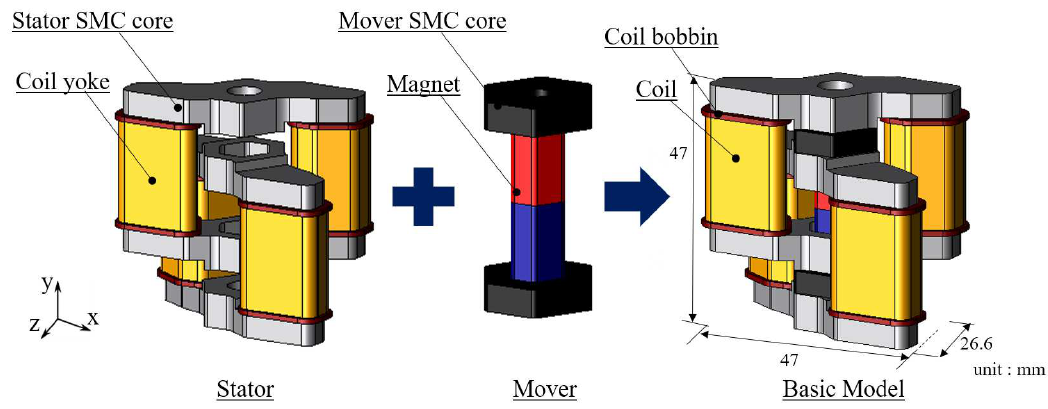
Figure 1. Structure of basic